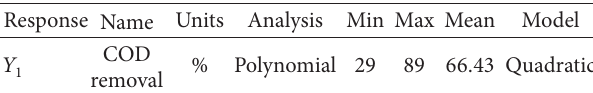
Table 3: The CCD using the coded factors. Table 4: Design summary for model of COD removal in